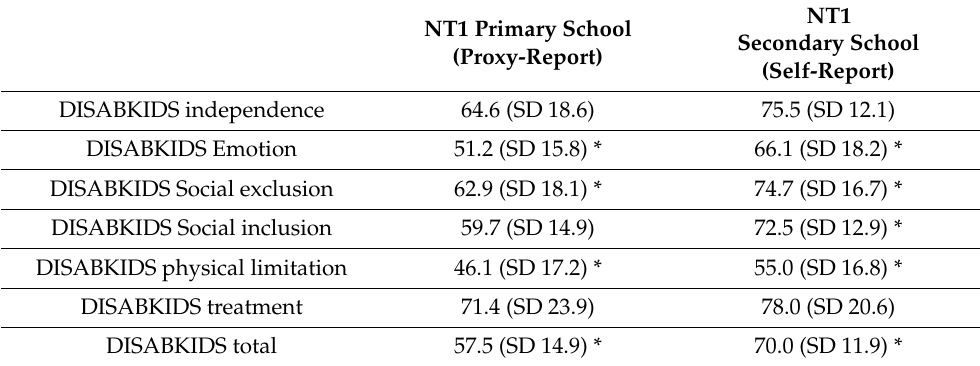
Table 2. Comparison of global functioning to norm scores of young people with